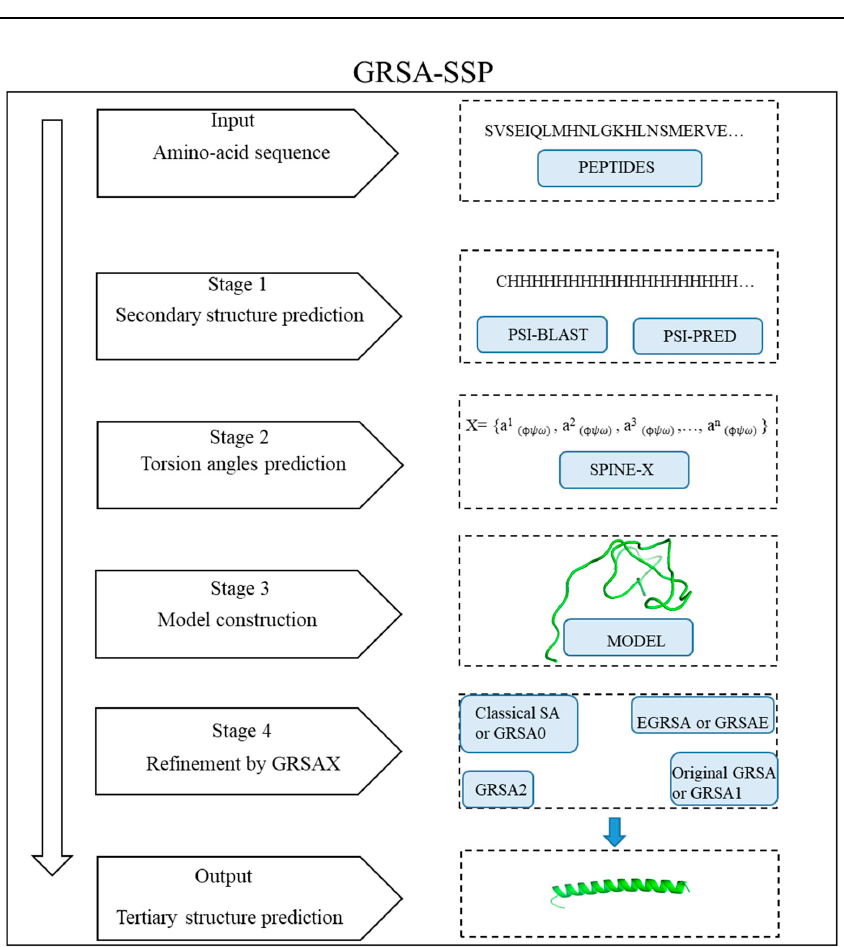
Figure 1. Methodology GRSA-SSP for peptide prediction.